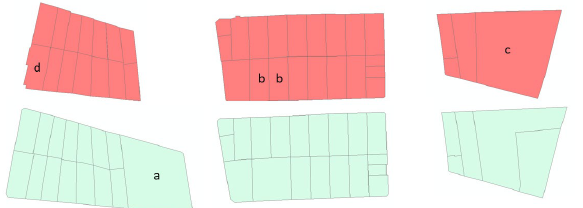
Figure 5. Red polygon: Cadastre map (base map), Green polygon: Tehran Municipality map. a) Enriching by adding the feature. b) Enriching by merging c) Enriching by splitting d) Enriching by modifying the feature.